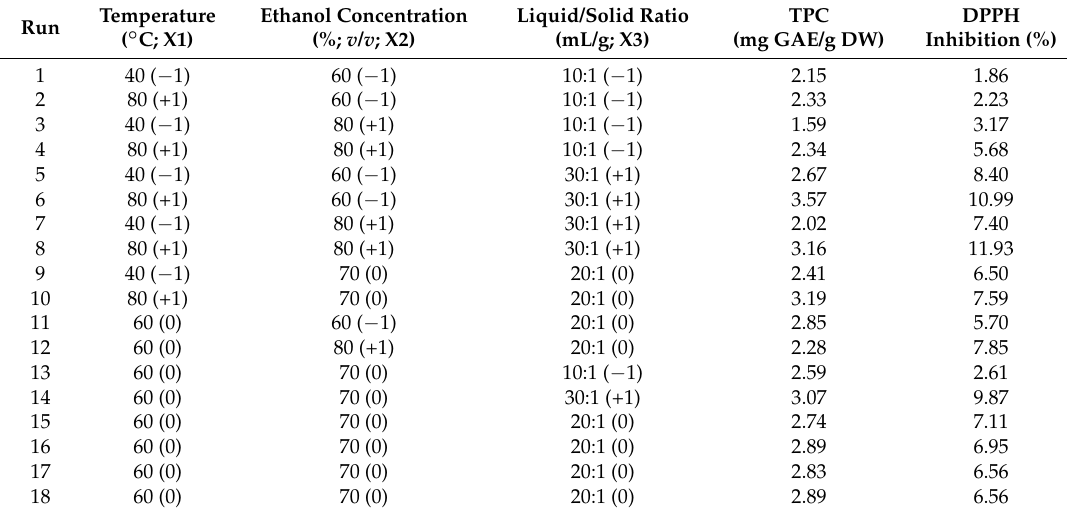
Table 1. Experimental design of three tested variables with the observed responses values for total phenolic content (TPC) and DPPH radical